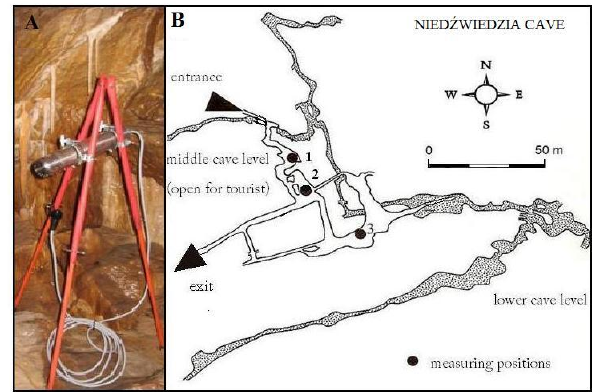
Fig. 3. Fig. 3. Plan of Bear Cave in Kletno with plotted sites of 222 Rn activity concentration measurements (B) and a photo of SRDN-3 probe operating at measurement site No. 3 (A).